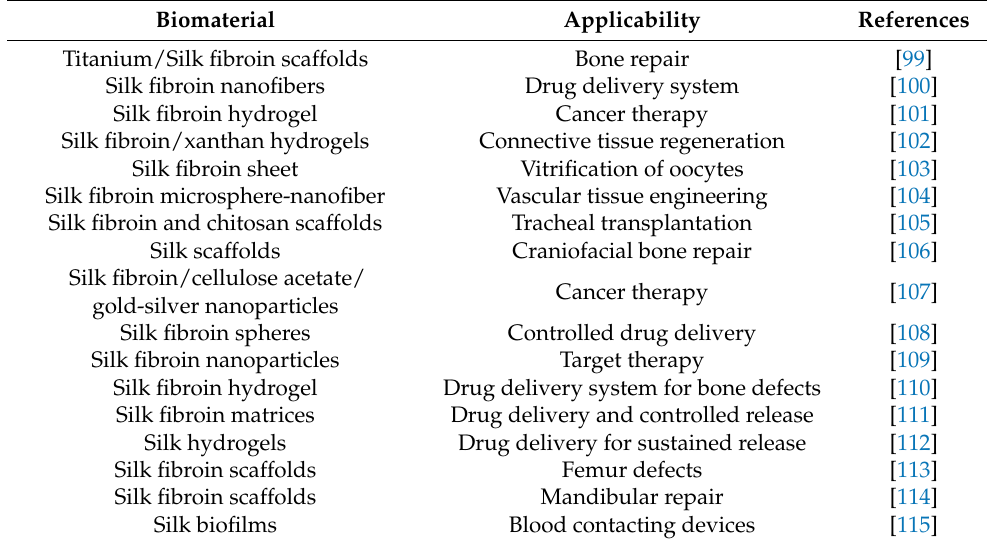
Table 6. Silk fibroin-based biomaterials and their